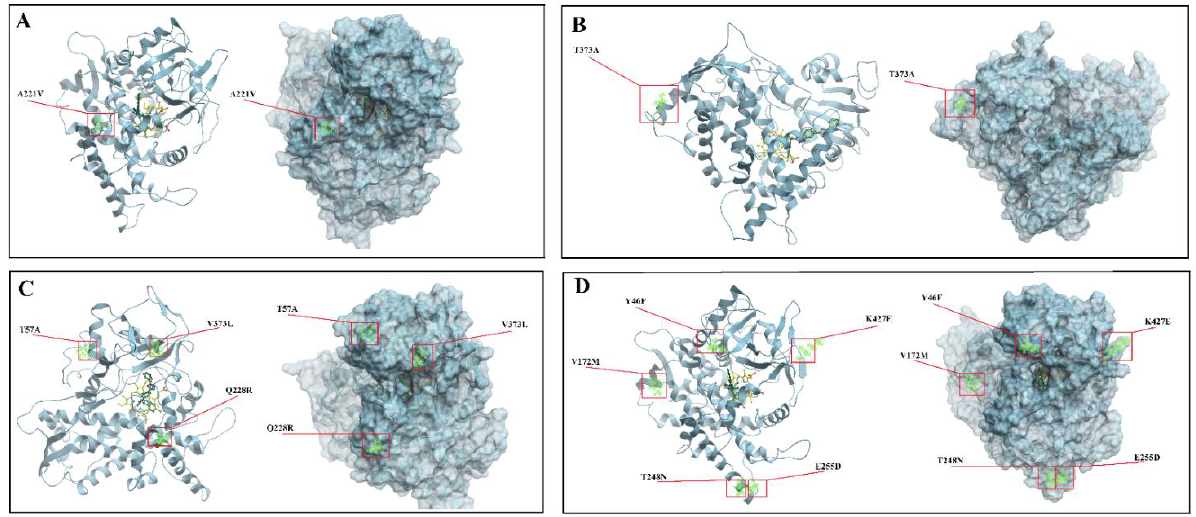
Figure 3. Homology modeling of CYP51A of the selected Aspergillus species and mutation mapping on the structures. Each structure was shown in two different presentations. ( A ) ( A. terreus ), ( B ) ( A. tubingensis ), ( C ) ( A. niger ) ( D ) ( A. fumigatus